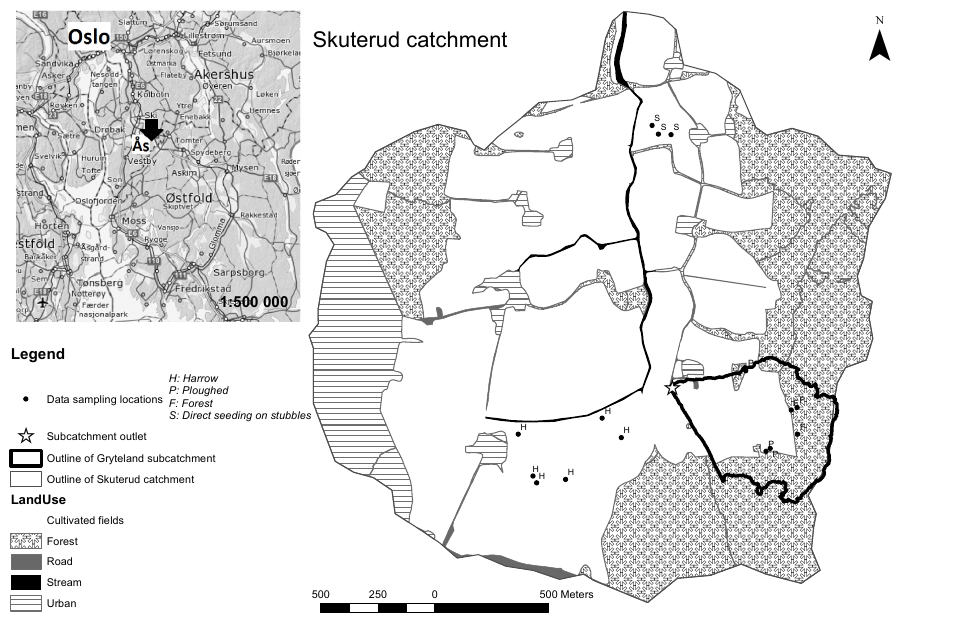
Figure 1. Outline and land use of the Skuterud catchment. The sub-catchment Gryteland is outlined in black. Data sampling locations are indicated. The inserted map in upper left corner indicates the location of the catchment. Land use map obtained from Bioforsk. Norway map obtained from http://www.skogoglandskap.no/kart/kilden.